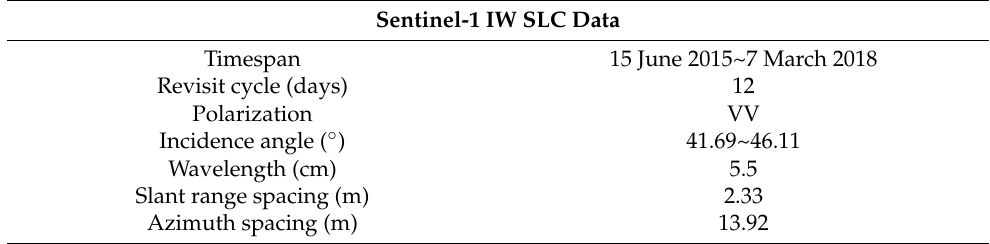
Table 1. Parameters of Sentinel-1 (Interferometric Wide) IW Single Look Complex (SLC)